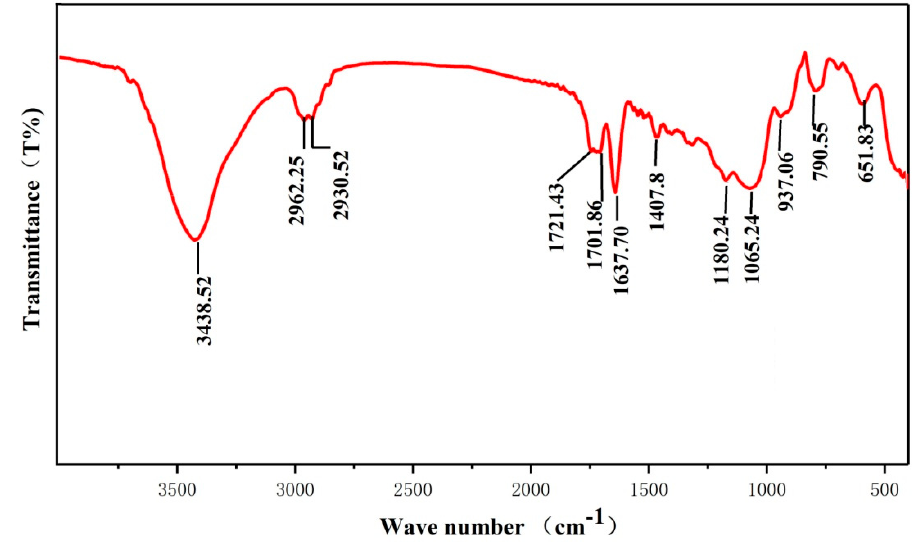
Figure 4. FT-IR spectra of the PEO-S2 sample.